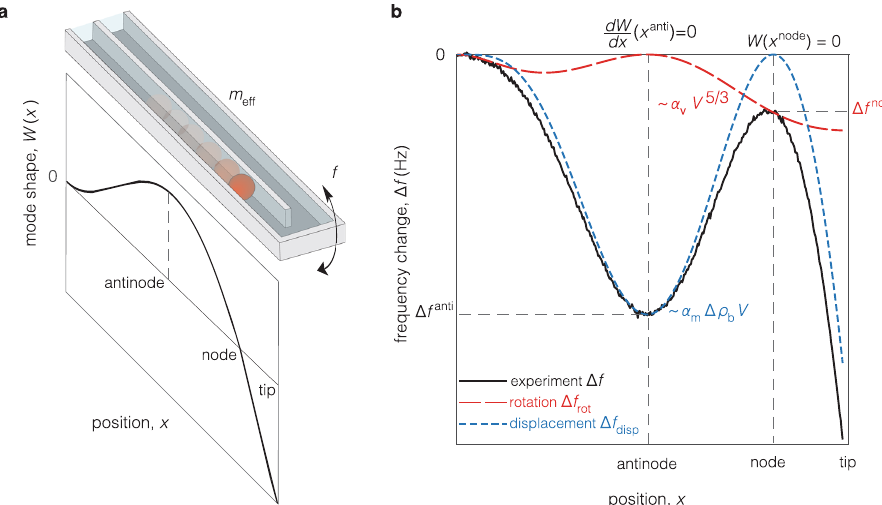
Fig. 3 Experimental realization of local rotation in microcantilevers. a Schematic of a particle (red) fl owing inside the cantilever, with effective mass, m eff , driven in its second fl exural mode, with resonant frequency f ; W x ð Þ speci fi es the displacement at a position x along the length of the cantilever. At the node (i.e., where W ( x node ) ¼ 0), there is local rotation only, dW = dx ð x node Þ ≠ 0 : , b Frequency change, Δ f , induced by a particle with nonzero buoyant mass m b ¼ ρ (cid:4) ρ , and volume V . The experimental signal, Δ f (black), consists of two signals: one (shown here for m 0) as the product of buoyant density, Δ ρ b < b p due to rotation Δ f rot (red), and one due to displacement Δ f disp (blue). Δ f anti and Δ f node denote the signals at the antinode and node positions respectively. The parameter α represents the mass discrepancy in the displacement signal 22 m